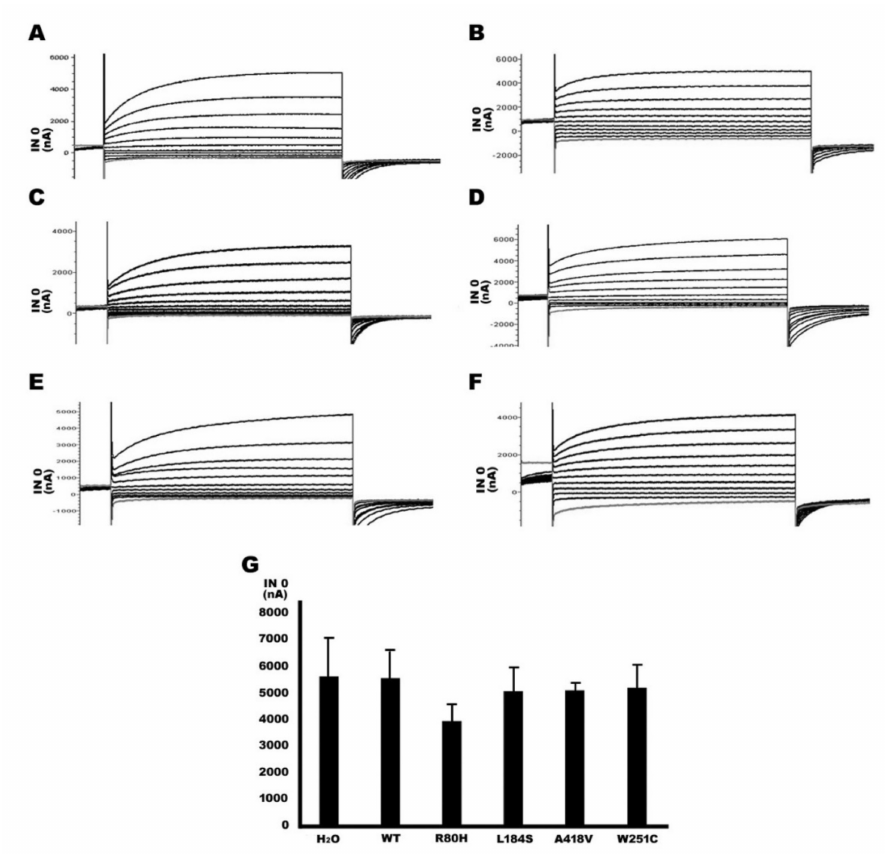
Figure 6. Serine protease trypsin can activate ENaC to produce Na + current in Xenopus oocytes. The three rat ENaC subunits and one of water, WT, or mutant TMPRSS3 were co-injected into Xenopus oocytes. After injection, the oocytes were treated with trypsin and then Na + currents were recorded. ( A ) After trypsin treatment, the ENaC was significant activated, producing Na + currents in the water (H 2 O) group. ( B ) In the TMPRSS3WT group, whether there was a trypsin treatment or not did not a ff ect the ENaC activation and the Na + currents. ( C – F ) All of the four missense mutation groups were very similar to the water group, and ENaC could be activated, increasing the Na + currents. ( G ) In the quantitative analysis, 10 Xenopus oocytes were treated by trypsin and measured by ENaC-mediated INa in each group. ( n ≥